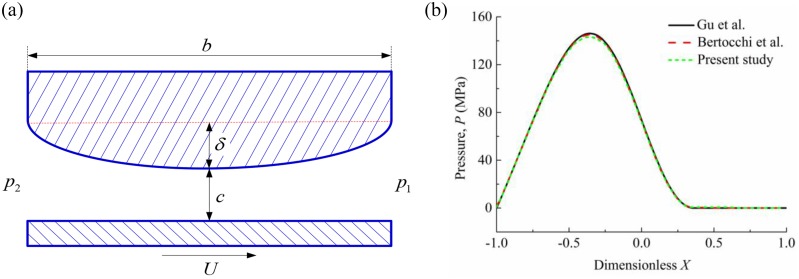
Model validation.(a) simulation conditions. (b) oil film pressures obtained by Gu et al.’s [28], Bertocchi et al. ‘s [41] and present model.